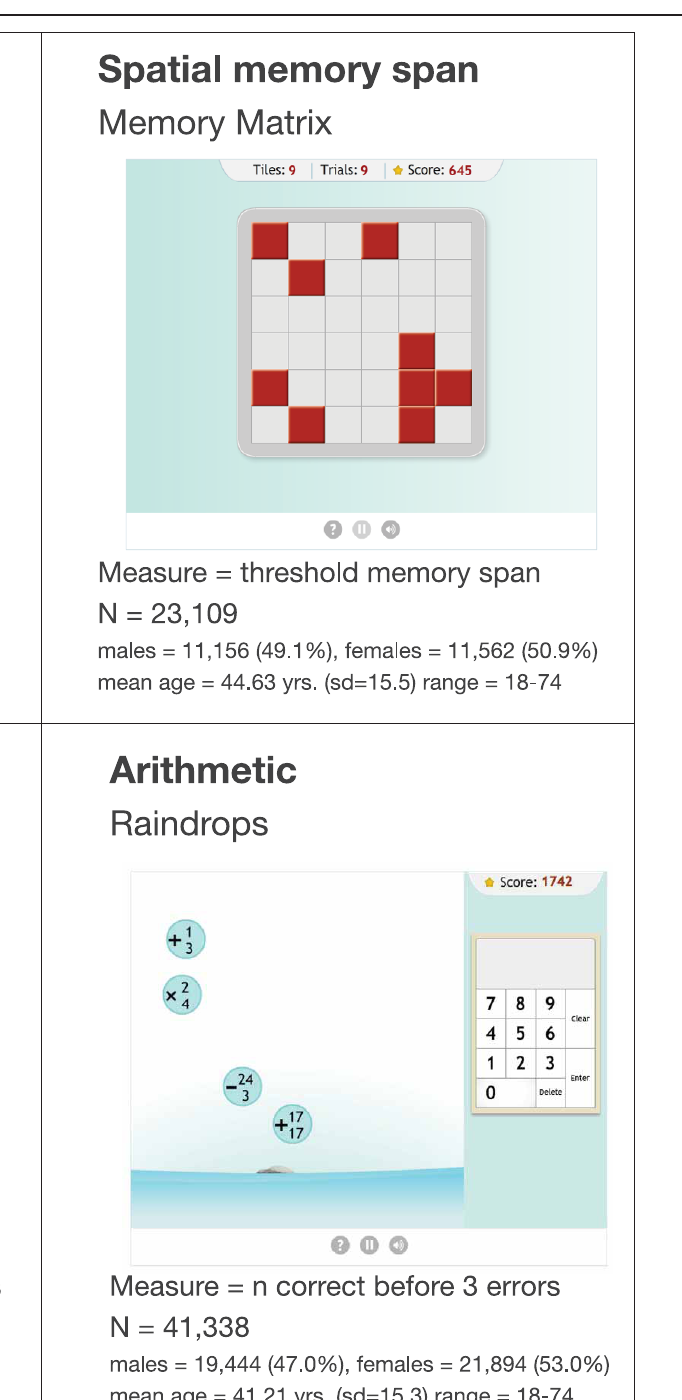
Frontiers in Human